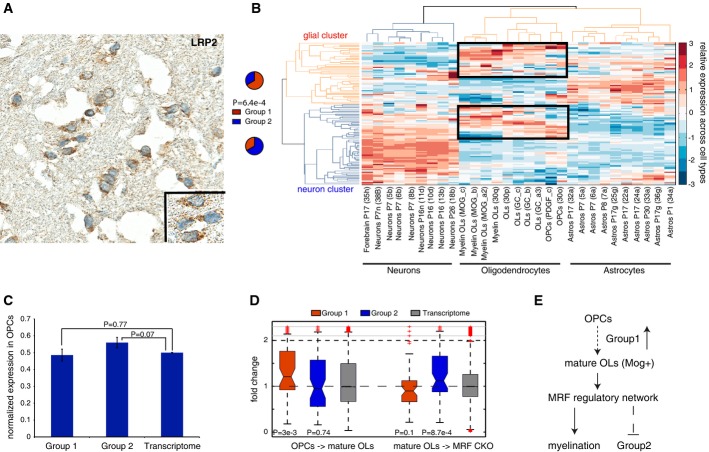
Cell-type expression of module #13 in oligodendrocytes
Immunohistochemistry analysis in the corpus callosum. Staining of LRP2 in the human corpus callosum reveals that the major cell population in the corpus callosum is the oligodendrocytes (the blue round nuclei), which express LRP2 stained in brown. A zoom-in view is shown in the inset.

Neural cell-type expression of the orthologous module #13 in mouse brain. Gene expression in different neural cell types was hierarchically clustered into the three major cell types in brain (neurons, oligodendrocytes and astrocytes). The clustering grouped genes in module #13 into a neuron cluster and a glial cluster, enriched for Group 1 and 2 genes, respectively. The fraction of Group 1 (red) and 2 (blue) genes in the glial and neuronal clusters were represented by the pie charts, with statistical significance determined by a chi-square test.

Overall expression of module #13 in cultured oligodendrocyte precursor cells (OPCs). Group 1 and 2 were expressed at a similar level as the transcriptome background in OPCs. The statistical significance was determined by Wilcoxon rank-sum test, and the error bars represent one standard error.

The role of the module in oligodendrocyte (OL) development. Differentiation of OPCs into mature myelinating OLs (MOG+) led to a significant up-regulation of Group 1 genes (left, OPCs → mature OLs). On the other hand, conditional knockout (CKO) of the master myelination factor MRF from mature OLs led to a significant up-regulation of Group 2 genes (right, mature OLs → MRF CKO). The statistical significance was determined by Wilcoxon rank-sum test.

A proposed model. Up-regulation is associated with, or likely to contribute to, the differentiation of OPCs into mature myelinating OLs. The mature OLs acquire their myelination capacity by activating the MRF-mediated regulatory network, which also serves to repress expression of Group 2 genes.